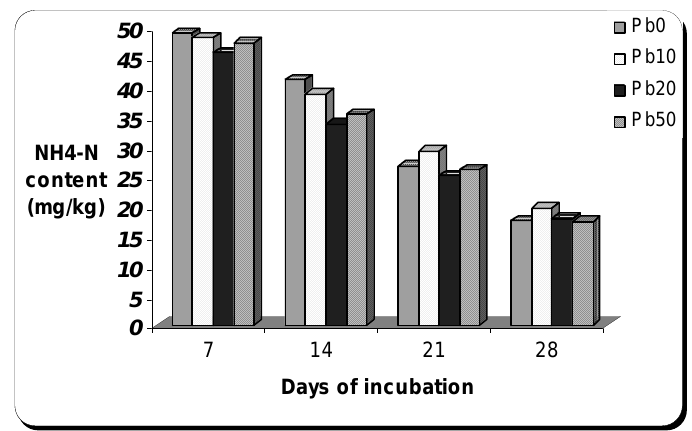
FIGURE 1 . Mean effect of different levels of Pb on the changes in NH 4 -N content in soil under 60% WHC.